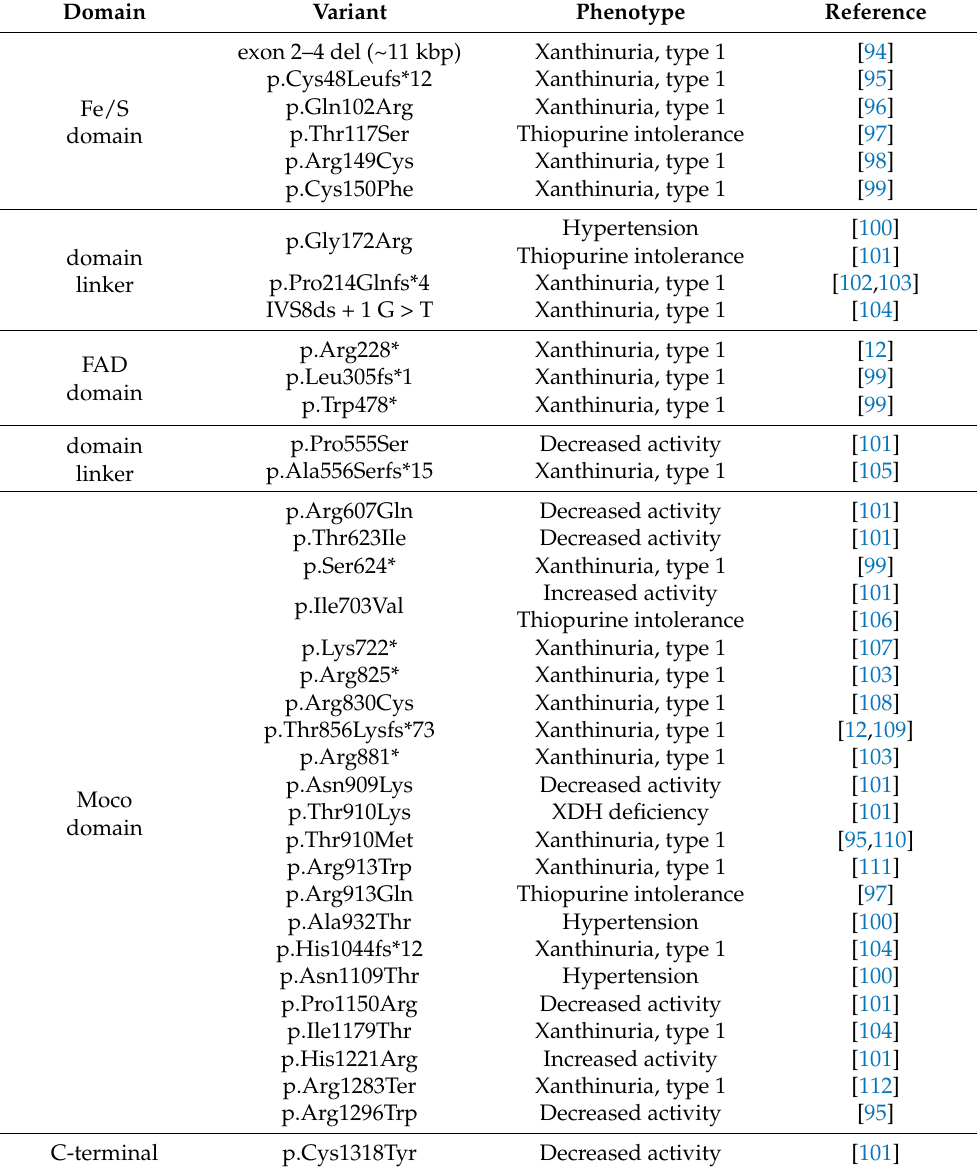
Table 1. Mutation sites of